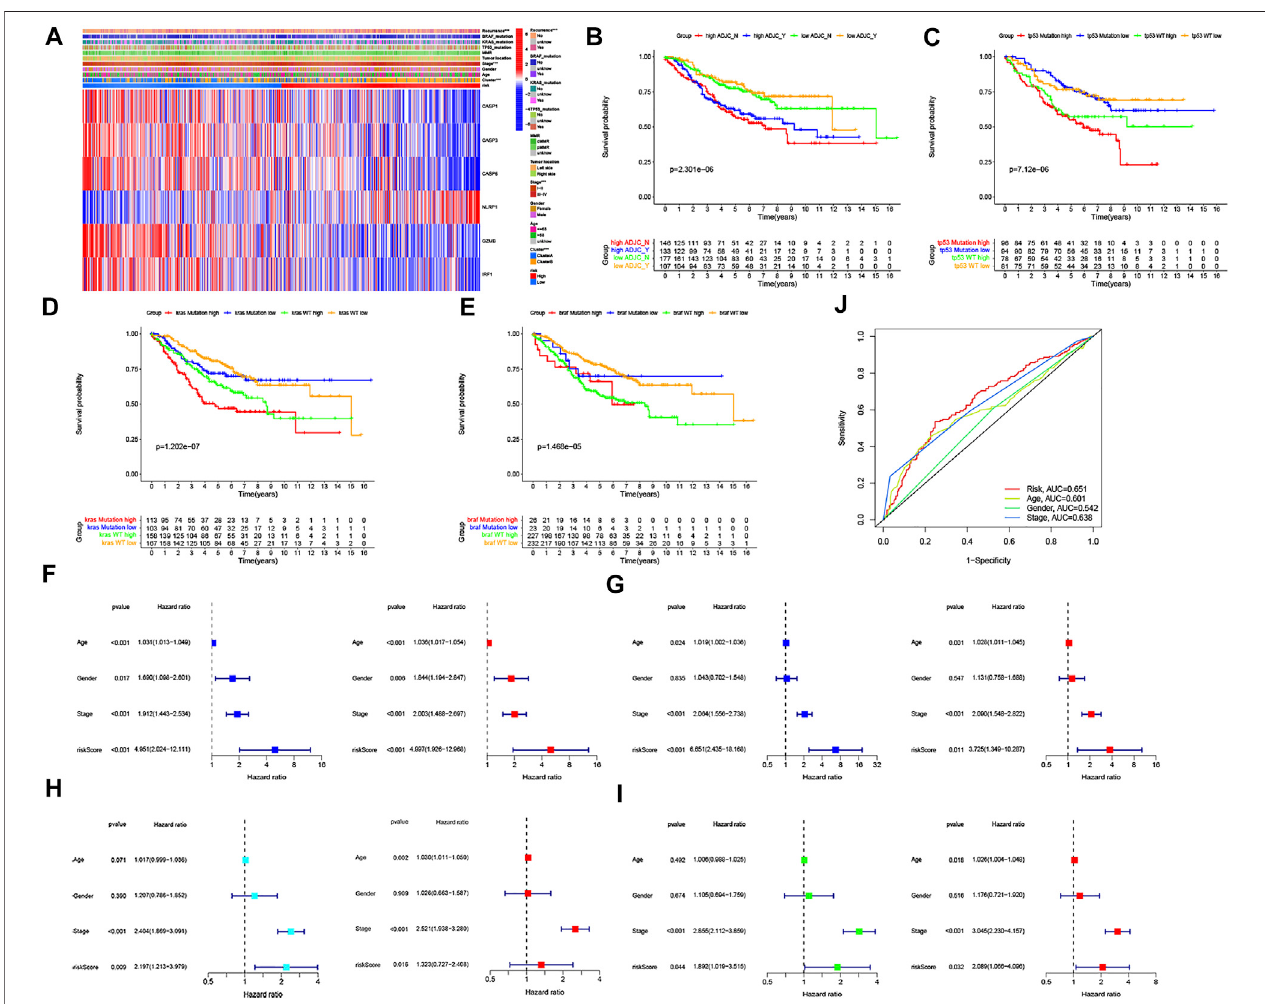
FIGURE 6 | Association of six PRG signatures with clinical characteristics and the univariate and multivariate Cox regression analyses for the risk score. (A) HeatmapofthecorrelationofsixPRGsignatureswithtwoCRCsubtypesandclinicalcharacteristics,*** p < 0.001. (B – E) Kaplan – MeiercurveanalysisofOSisshownfor patients classi fi ed according to adjuvant chemotherapy and the TP53/KRAS/BRAF mutation status and six PRG signatures. (F – I) Univariate Cox regression and multivariate Cox regression analyses for the two internal (divided GSE39582 cohort into F: training dataset and G: testing dataset, respectively) and external datasets (H: TCGA cohort, (I) GSE17536 cohort, respectively). (J) ROC curves of the clinical characteristics and risk